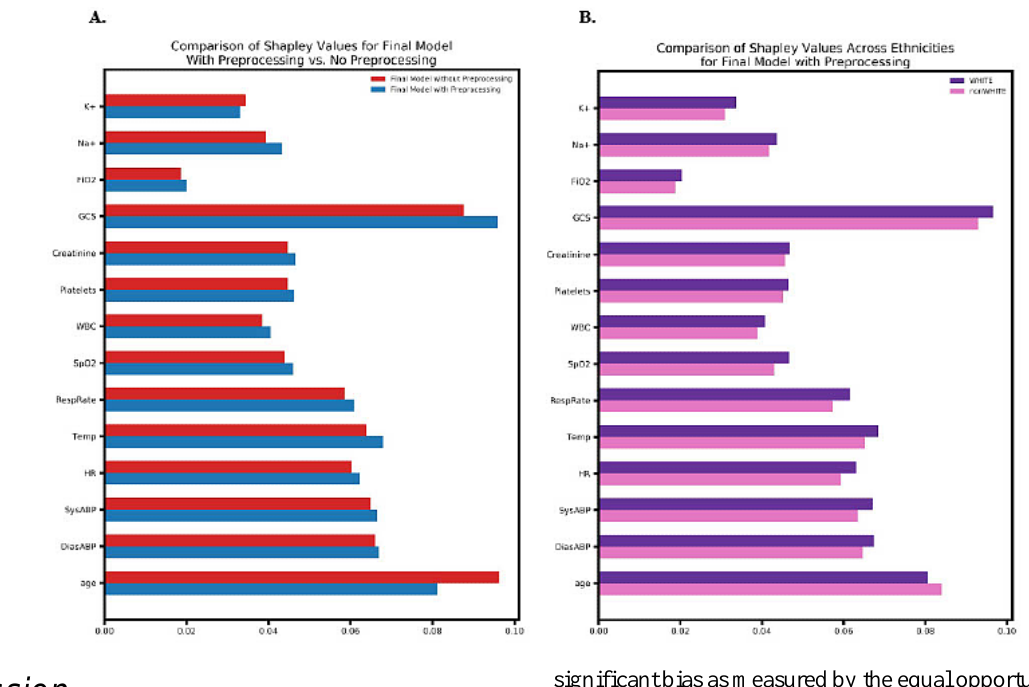
Figure 2. Comparison of feature importance between (A) models trained with and without preprocessing of the training data and (B) white and nonwhite subgroups on the model trained with preprocessing of the training